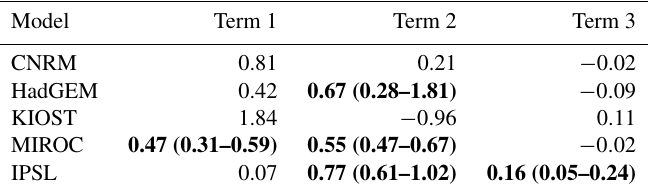
Table 4. Contribution to projected change in F Rec from terms 1 (second column), 2 (third column), and 3 (fourth column) of Eq. (A4). Bolded values represent significance at 95% using a bootstrapping method. For significant values, the 95% confidence interval is shown in